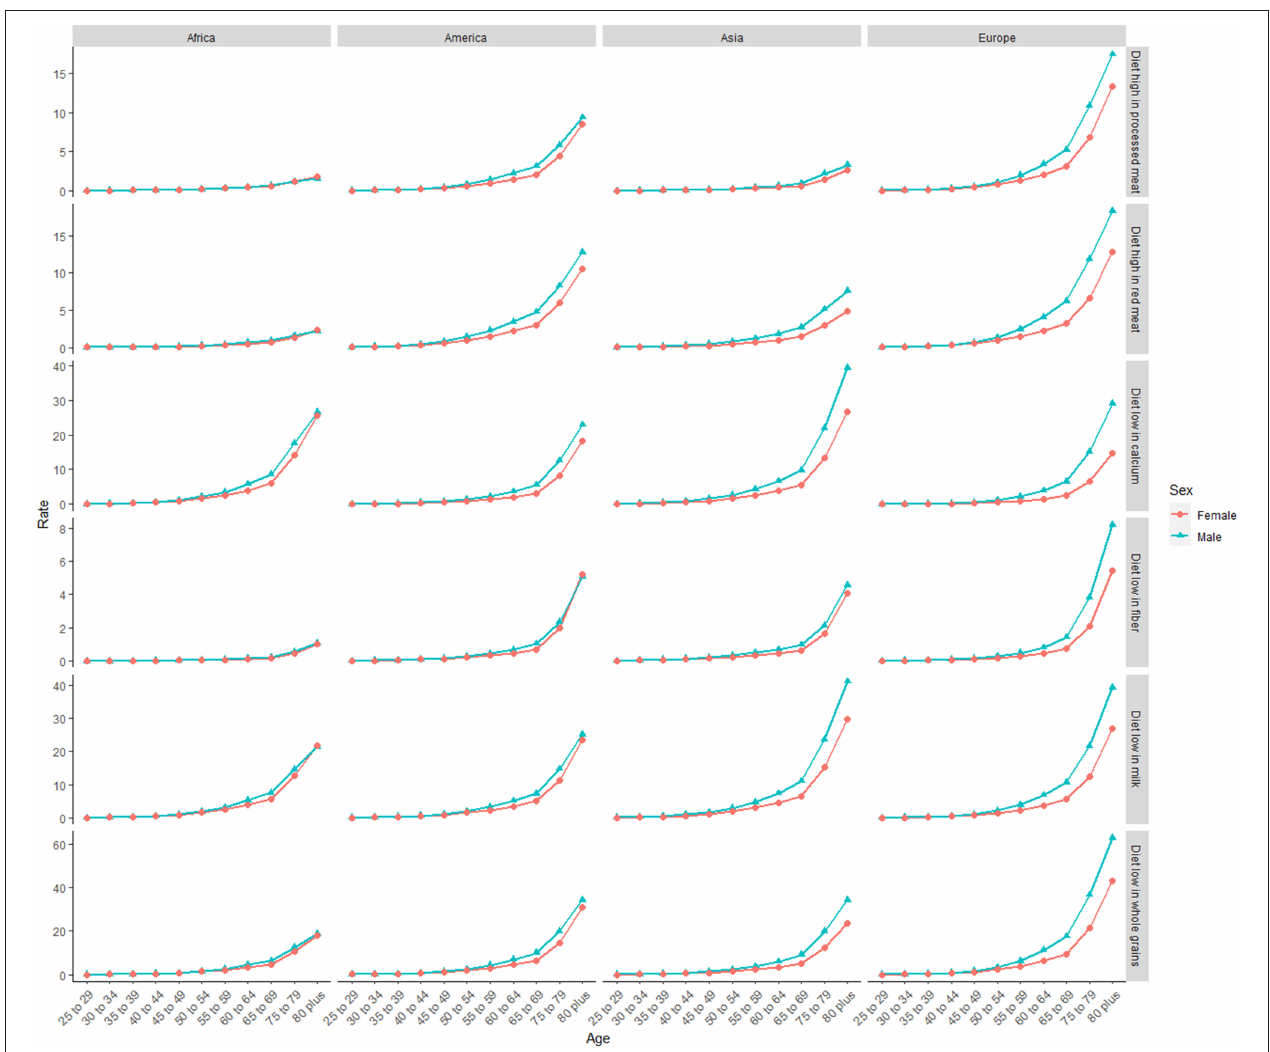
FIGURE 1 | The death rate of six dietary risk factors related to colorectal cancer among four world regions in 2019. The vertical axis is the death rate (per 100,000 persons). The horizontal axis represents different age groups.